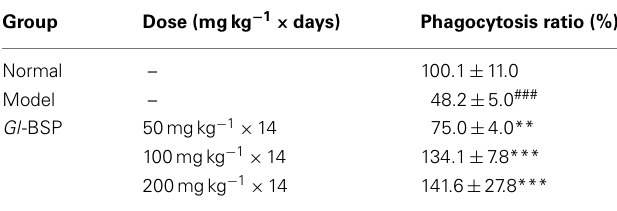
Table 5 | Effect of Gl -BSP on phagocytosis by peritoneal macrophages in S180-bearing mice ( n = 5, ¯ x ±